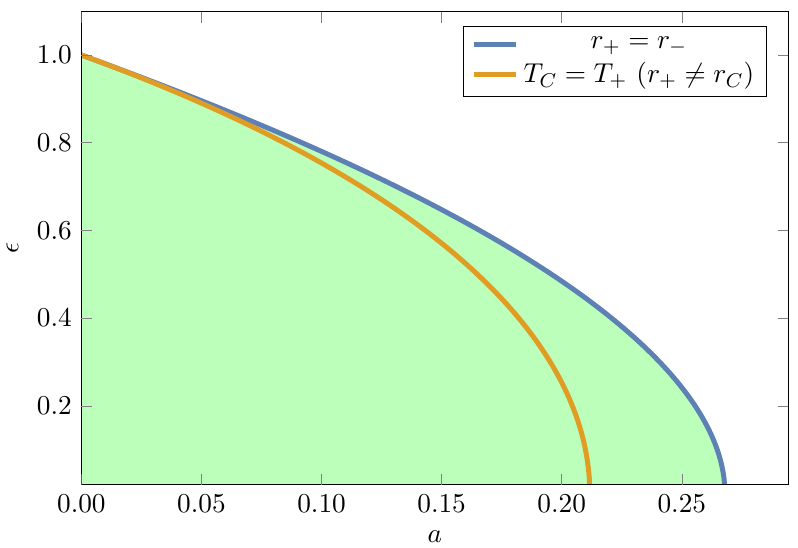
Figure 3 . Kerr-de Sitter con(cid:12)guration space in terms of ( (cid:15); a ) with L = 1. The green region corre- sponds to the same one in (cid:12)gure 2 of Kerr-de Sitter black holes. The (cid:15) = 0 line corresponds to the rotating Nariai limit r + = r C and the point (cid:15) = 1 ; a = 0 corresponds to empty de Sitter spacetime. The blue line corresponds to the extremal limit r + = r (cid:0) , while the orange line corresponds to the equal temperature condition T C = T + for r + = r C ( lukewarm 6